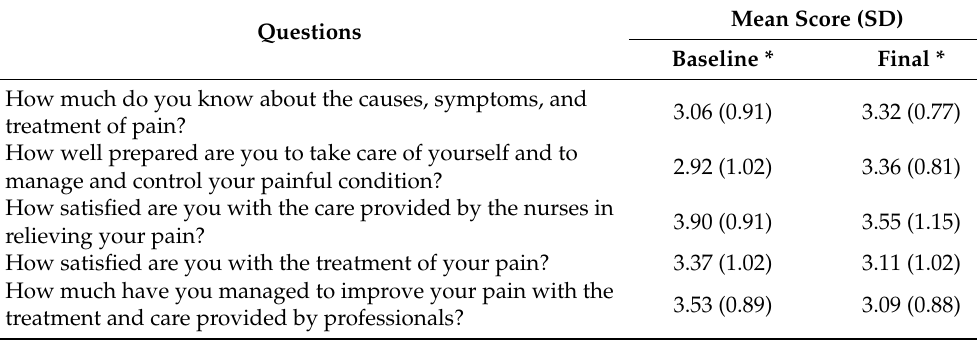
Table 4. Ad hoc questions about knowledge and satisfaction. Patient response